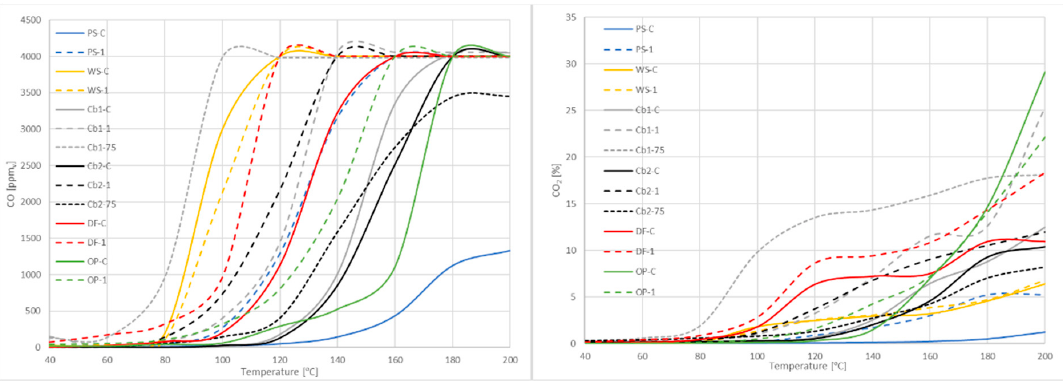
Figure 6. Gas emission.